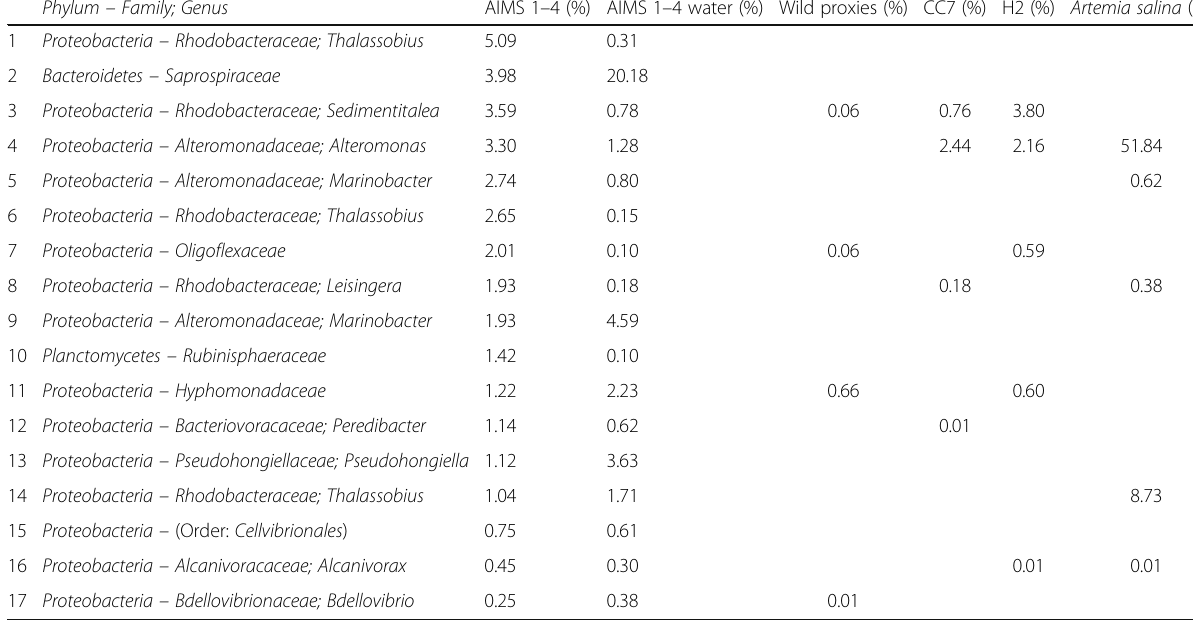
Table 5 Relative abundance of bacterial ASVs a present in every AIMS1 – 4 sample, and co-occurrence in other samples b across all samples within each sample type Phylum – Family;